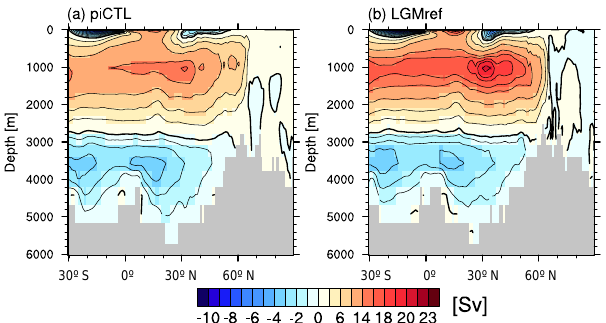
Figure 6. Atlantic meridional overturning stream function for (a) the pre-industrial state and (b) the glacial state. Red shading indicates clockwise, and blue shading indicates anticlockwise flow. Note that the contour levels are not symmetric.